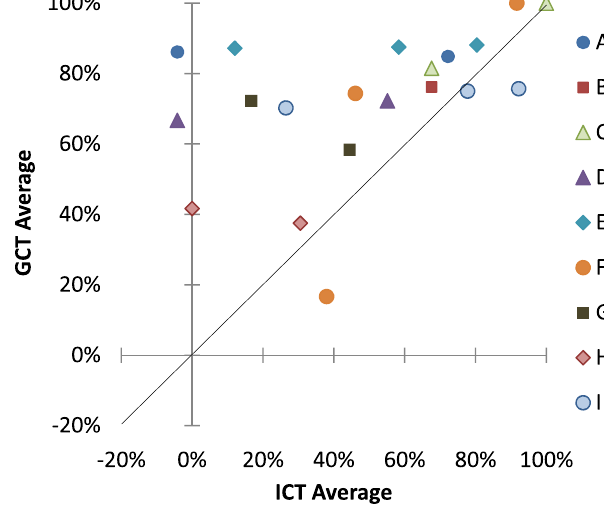
FIG. 1. Student performance on ICT vs RQ, averaged over all comparison questions. The difference between the means of the RQ and ICT scores is significant ( p ¼ 0 . 004 ). Error bars are not shown on the plot for clarity; the average standard error was (cid:2) 6% for the RQ and (cid:2) 8% for the ICT.